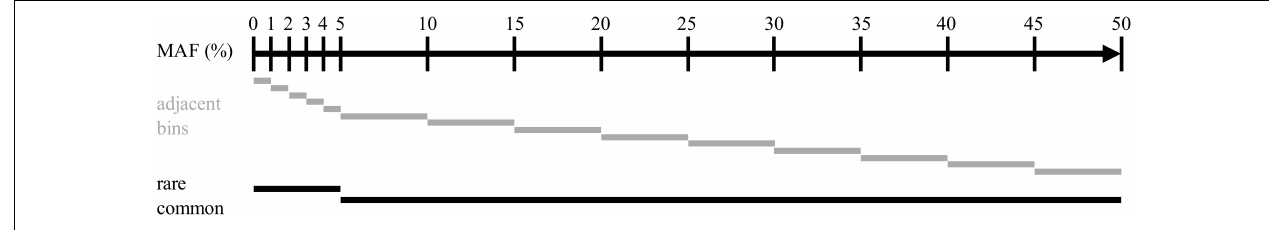
FIGURE 3 | Representation of the distribution of the intervals of minor alleles frequencies used for assessing imputation